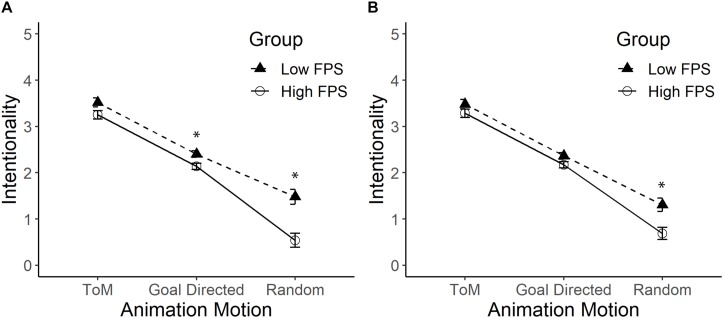
Mean and standard error of intentionality for Stickman figures displayed at low fps rate and high fps rate with ToM, GD, and R movements. Panel (A) shows the comparison between the Stickman figures displayed at a low fps rate and the Stickman figures displayed at a high fps rate. Panel (B) shows the comparison by statistically controlling the effect of the use of human nouns. The asterisk (*) indicates significant differences. Pearson’s Correlation between intentionality in each type of movement with the score for the use of human nouns (from 1 to 12) was higher in R movements (r = 0.57, p < 0.01), and lower in GD (r = 0.31, p = 0.004) and ToM movements (r = 0.24, p = 0.03).